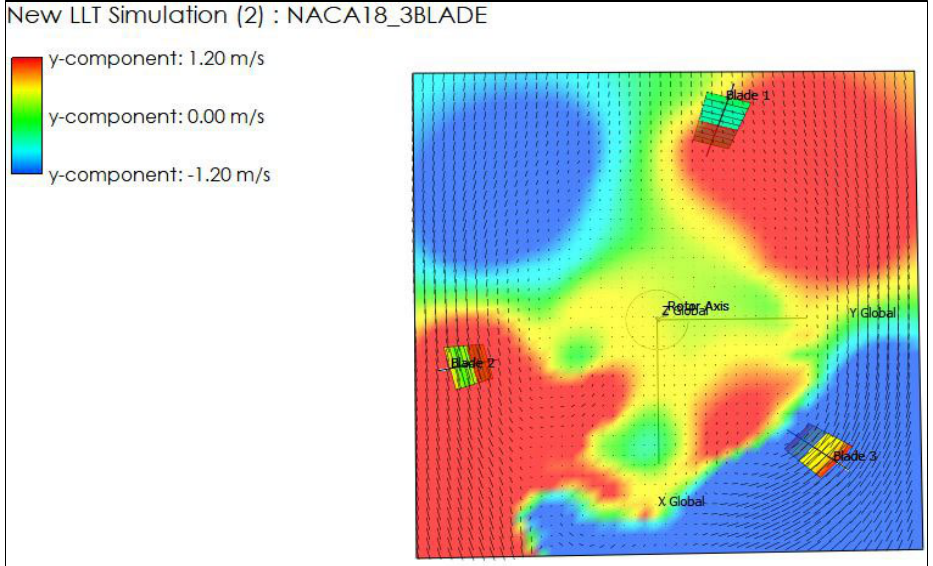
Figure 53. Three-bladed turbine velocity